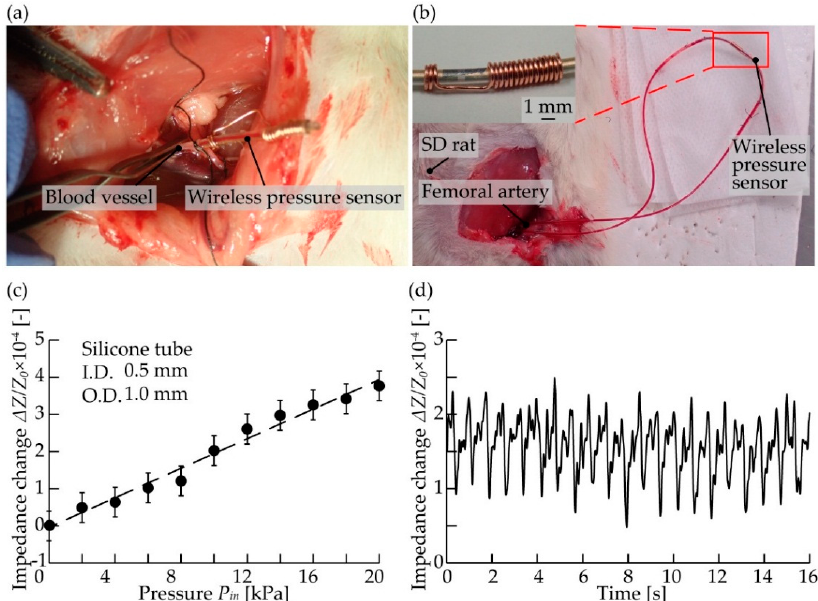
Figure 8. In vivo blood pressure monitoring. ( a ) A wireless pressure sensor connected to the femoral artery. ( b ) Setup for measuring blood pressure. ( c ) The relationship between impedance change and applied pressure. ( d ) Obtained signals of impedance change versus time in blood pressure measurement.